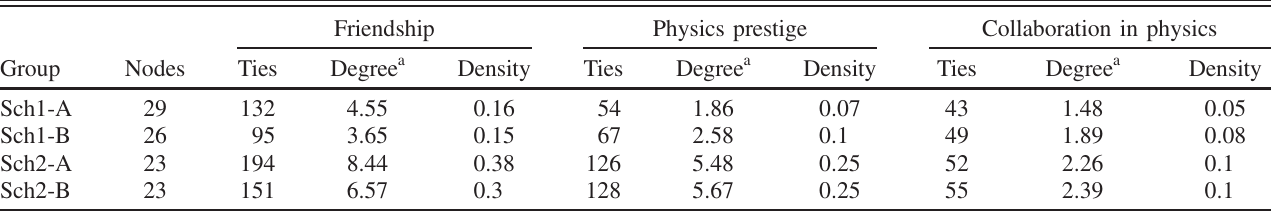
TABLE II. Descriptive statistics of directed networks: Friendship, physics prestige, and collaboration in physics. Friendship Physics prestige Collaboration in physics Group Nodes Ties Degree a Density Ties Degree a Density